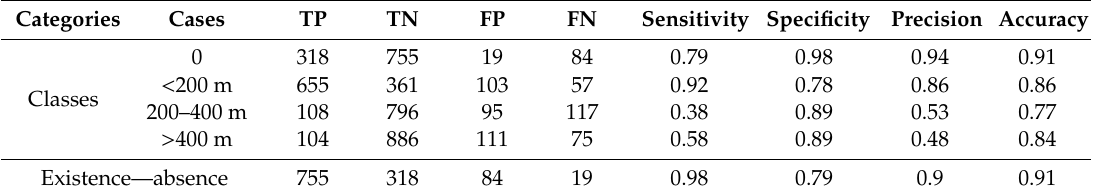
Table 2. The accuracy assessment results. Cases correspond to total TM length per analyzed